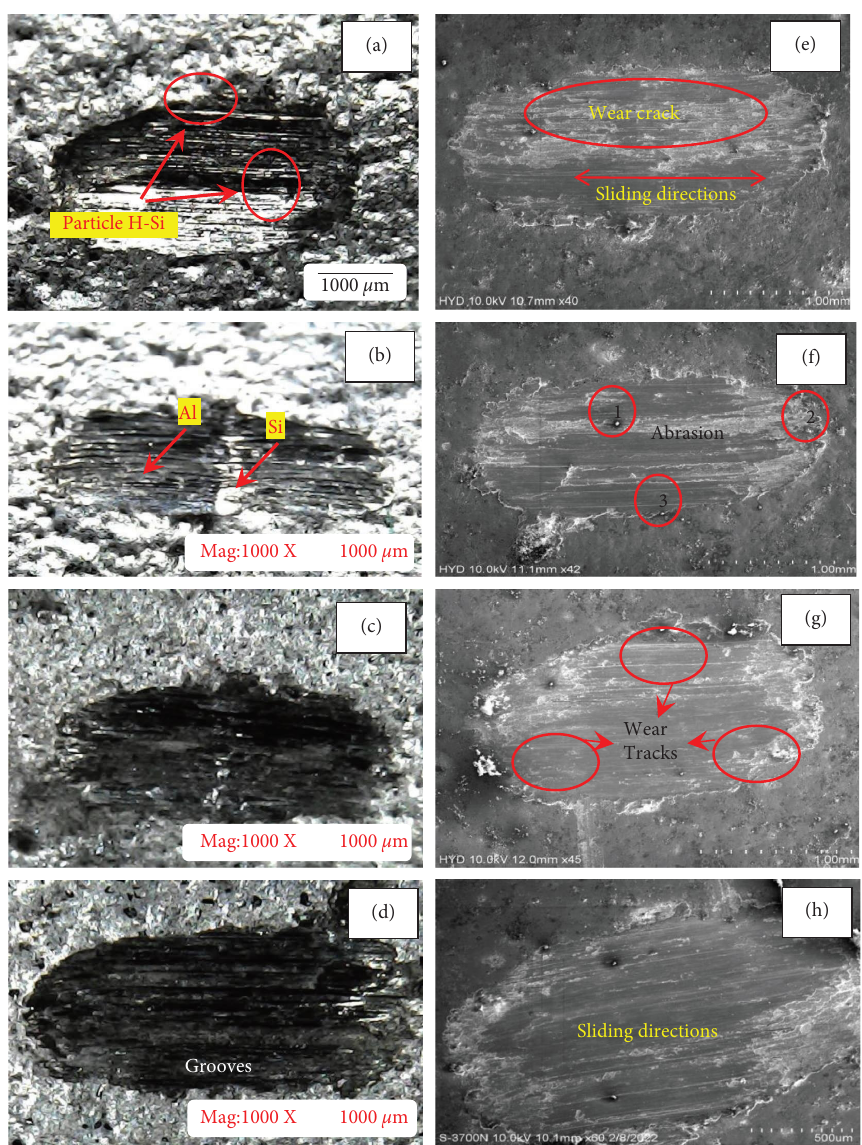
Figure 11: Micrographs of HAlSi24 under dry conditions at (a) 20N, (b) 30N, (c) 40 N, and (d) 50N load. Morphology of HAlSi24 under dry conditions at (e) 20N, (f) 30 N, (g) 40N, and (h) 50 N